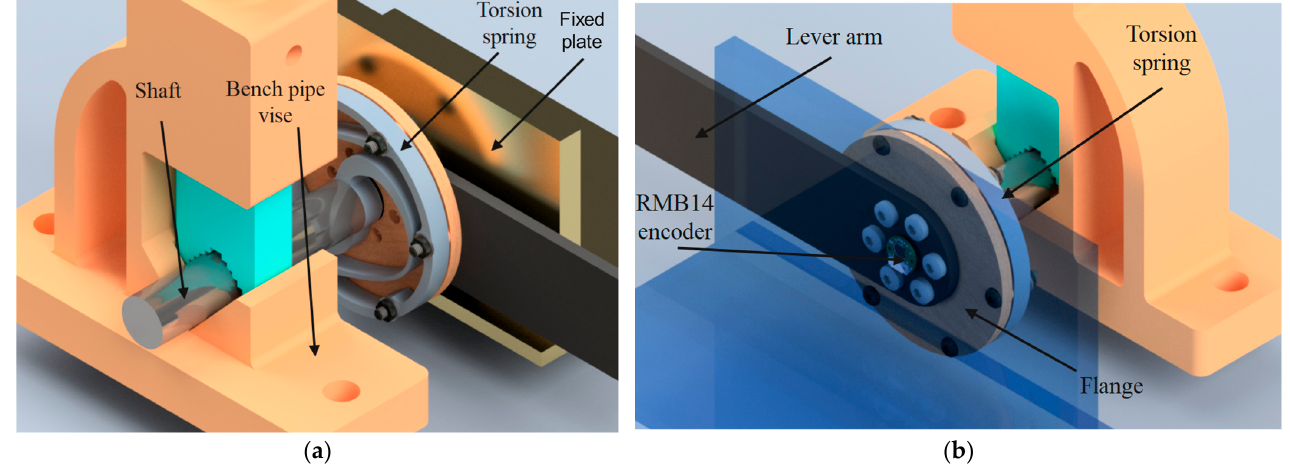
Figure 11. 3D rendering of the testbed of the torsion spring: ( a ) Front view and ( b ) Back view. Four bolts were used to secure the torsion spring’s inner diameter to the steel